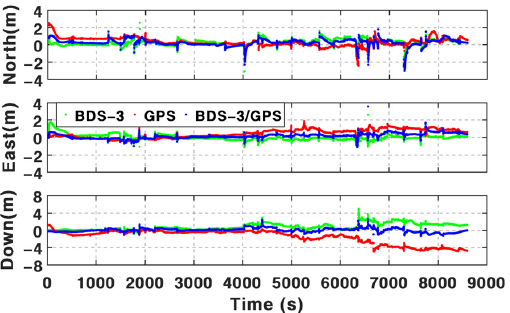
Figure 15. Positioning errors of undifferenced BSSD PPP/INS/ODO TCI with different GNSS using PPP-B2b correction.